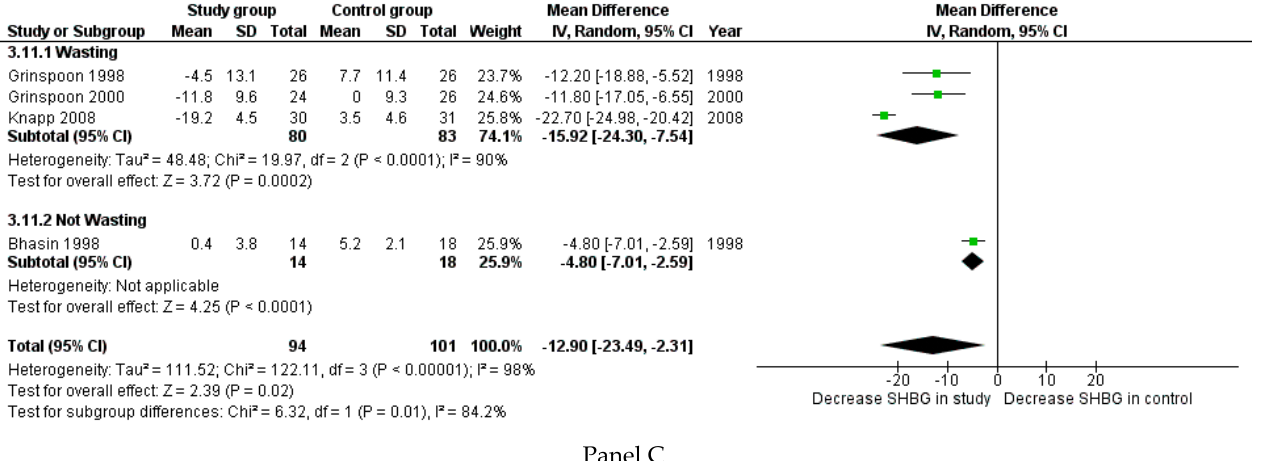
Figure 4. Forest plot reporting groups detected in the second literature search for changes in sex hormone binding globulin (SHBG) between study and control groups (Panel A ). Panel B reports the sensitivity analysis for hypogonadism, and Panel C shows the sensitivity analysis for wasting syndrome.